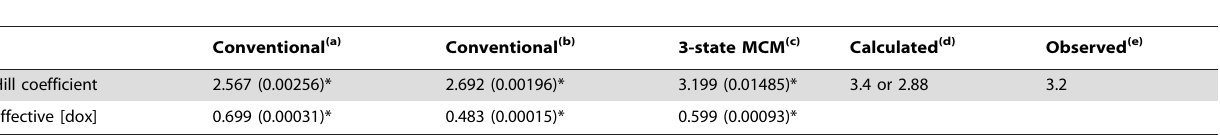
Conventional (a) Conventional (b) 3-state MCM (c) Calculated (d) Observed (e) Hill